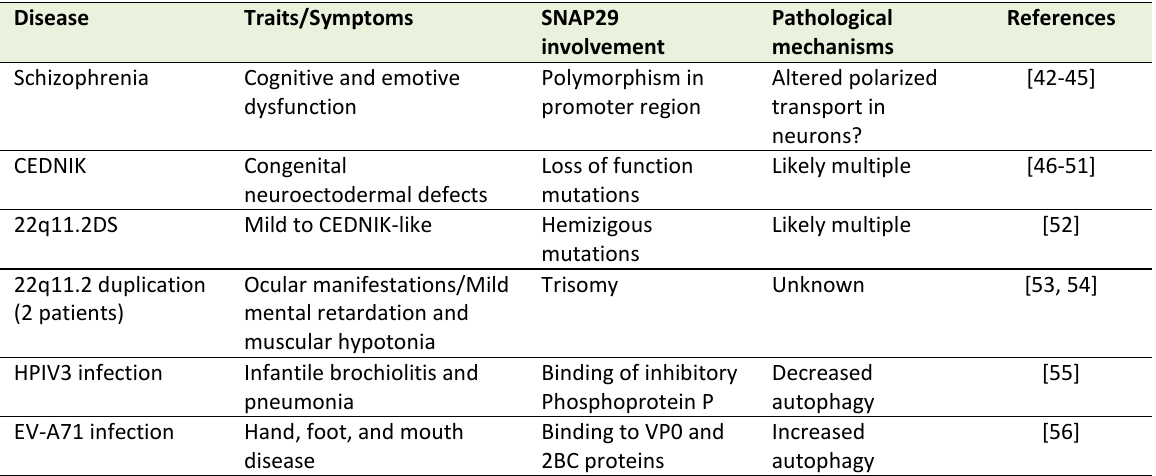
Table 1. List of diseases with proven alterations in SNAP29 (see text for details). Disease Traits/Symptoms